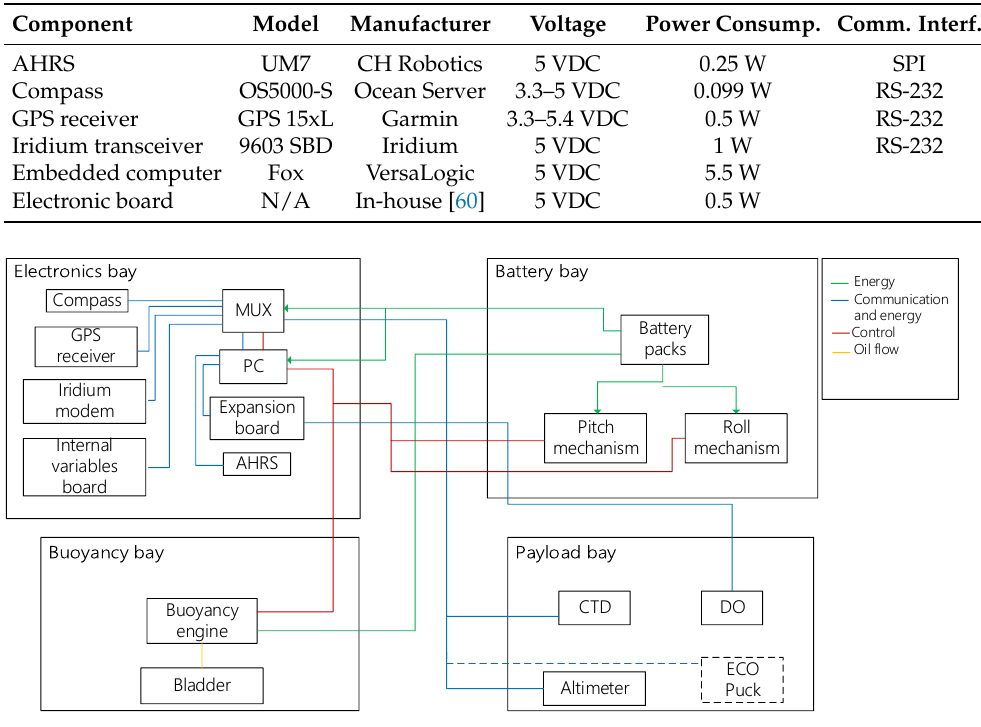
Figure 13. Physical